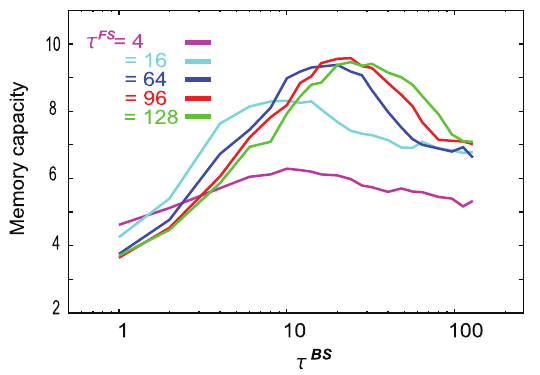
Figure 4. Memory capacity as a function of t BS for various values of t FS Memory capacity curves as a function of t BS are shown (See text for the definition of capacity). The other time scale, t NA , is fixed at a unit value. Memory capacity shows a peak when t BS satisfies the condition t NA % t BS % t FS If t FS is sufficiently large, our model can memorize almost all learned sets ( N ~ 10 ) at the time scale satisfying this condition. Here, T mem at each t FS is scaled by t FS , i.e., T mem = t FS is constant. Computed from the average over 100 learning processes for each t BS .